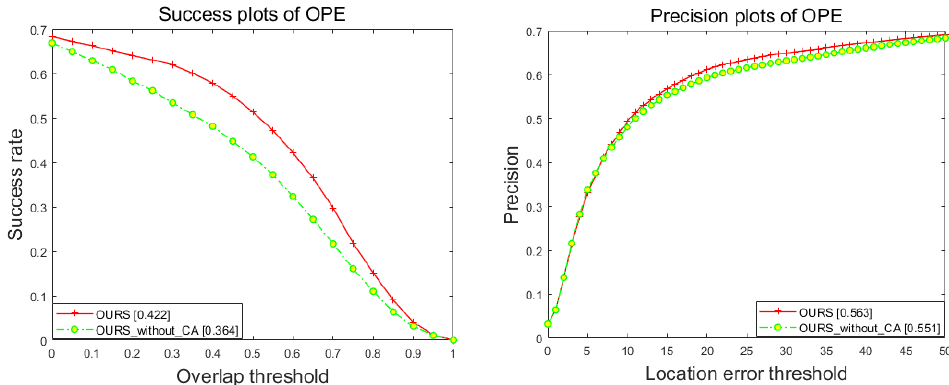
Figure 9. The success and precision plots of our tracker compared with which without adaptive appearance template updating strategy on the UAV123 dataset.